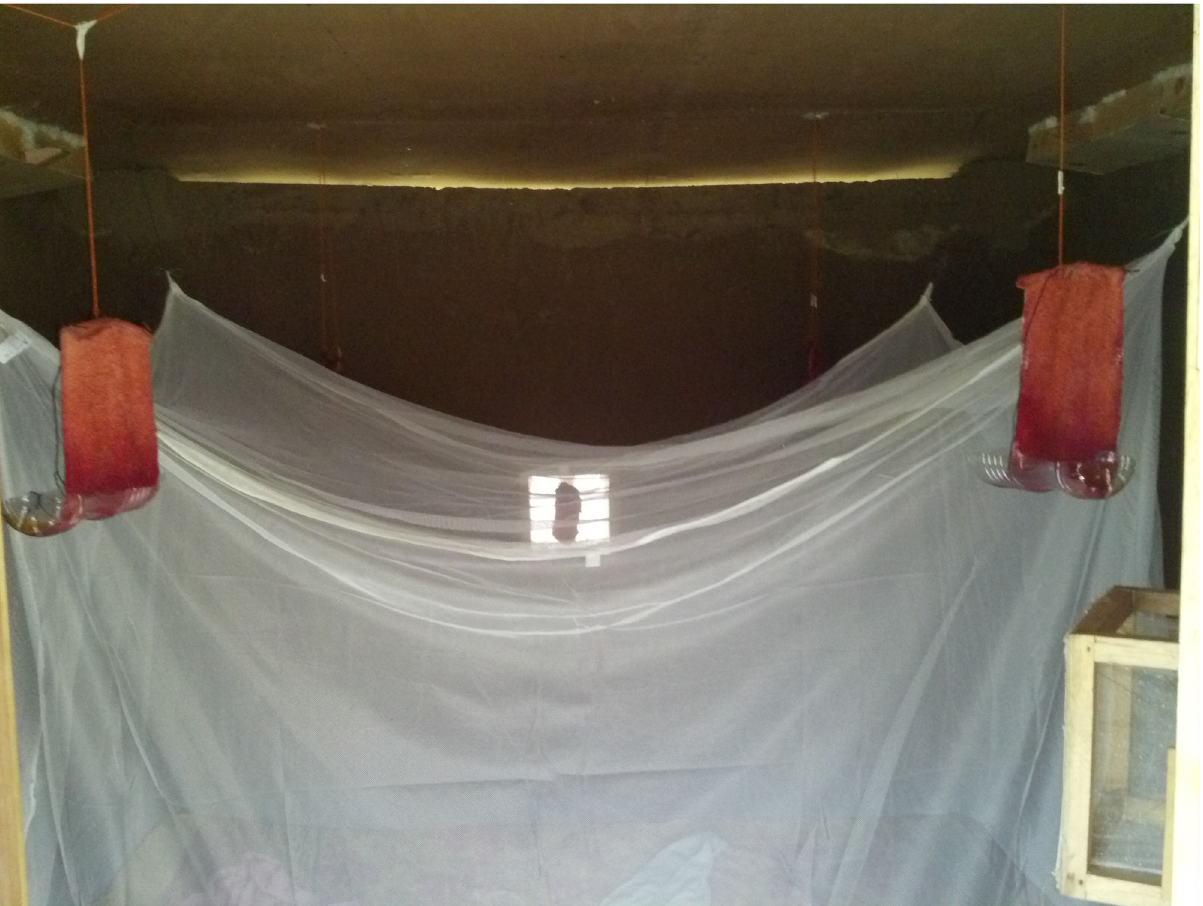
Figure 1. ATSB station positioning in experimental